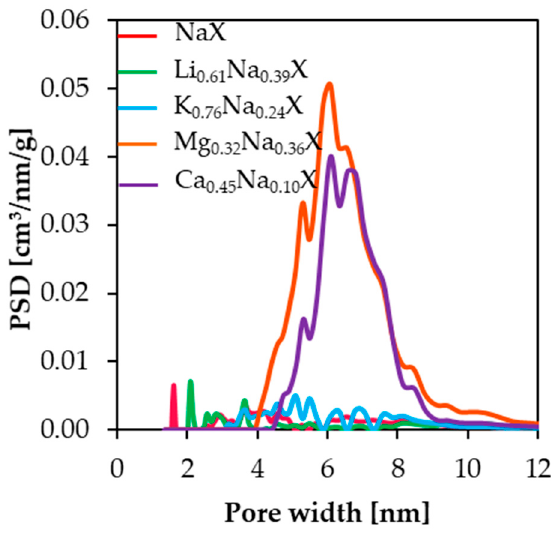
Table 2. Textural properties of the investigated samples.